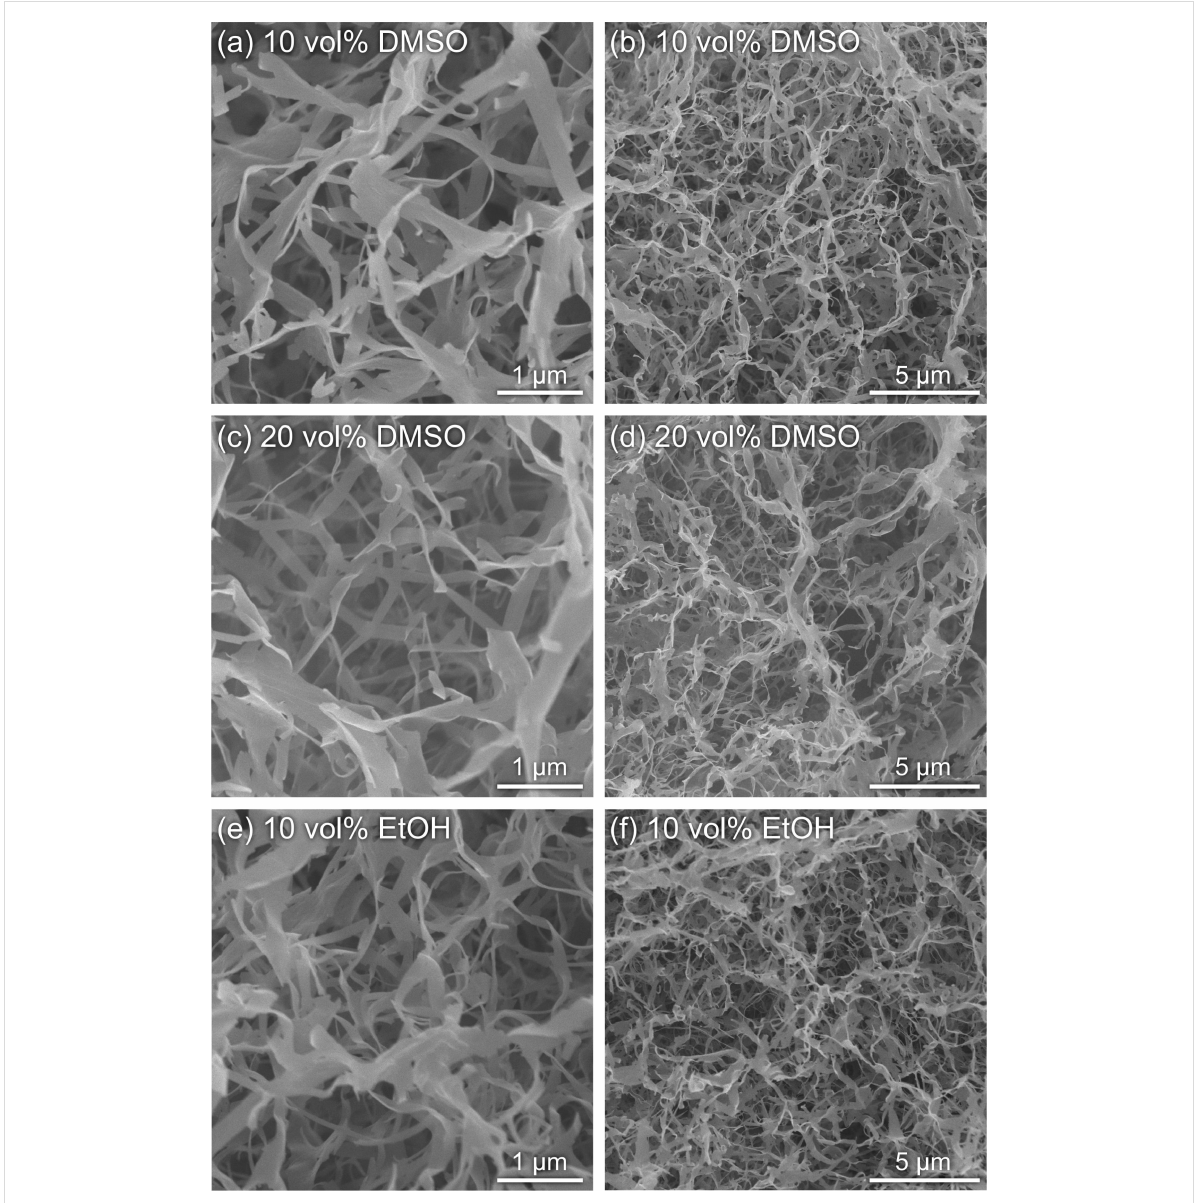
Figure 9: SEM images of the xerogels prepared from the gels synthesized with (a,b) 10 vol % DMSO, (c,d) 20 vol % DMSO, and (e,f) 10 vol % EtOH.